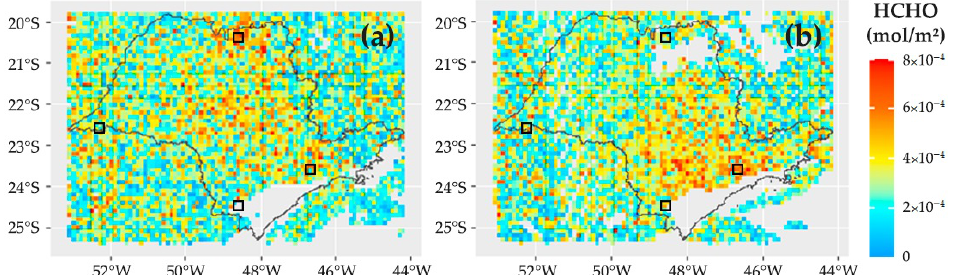
Figure 9. Vertical HCHO columns (12 p.m.–4 p.m. local time) over São Paulo State on ( a ) 5 October and ( b ) 6 October. The black squares indicate the locations of the four areas of interest showed in Figure